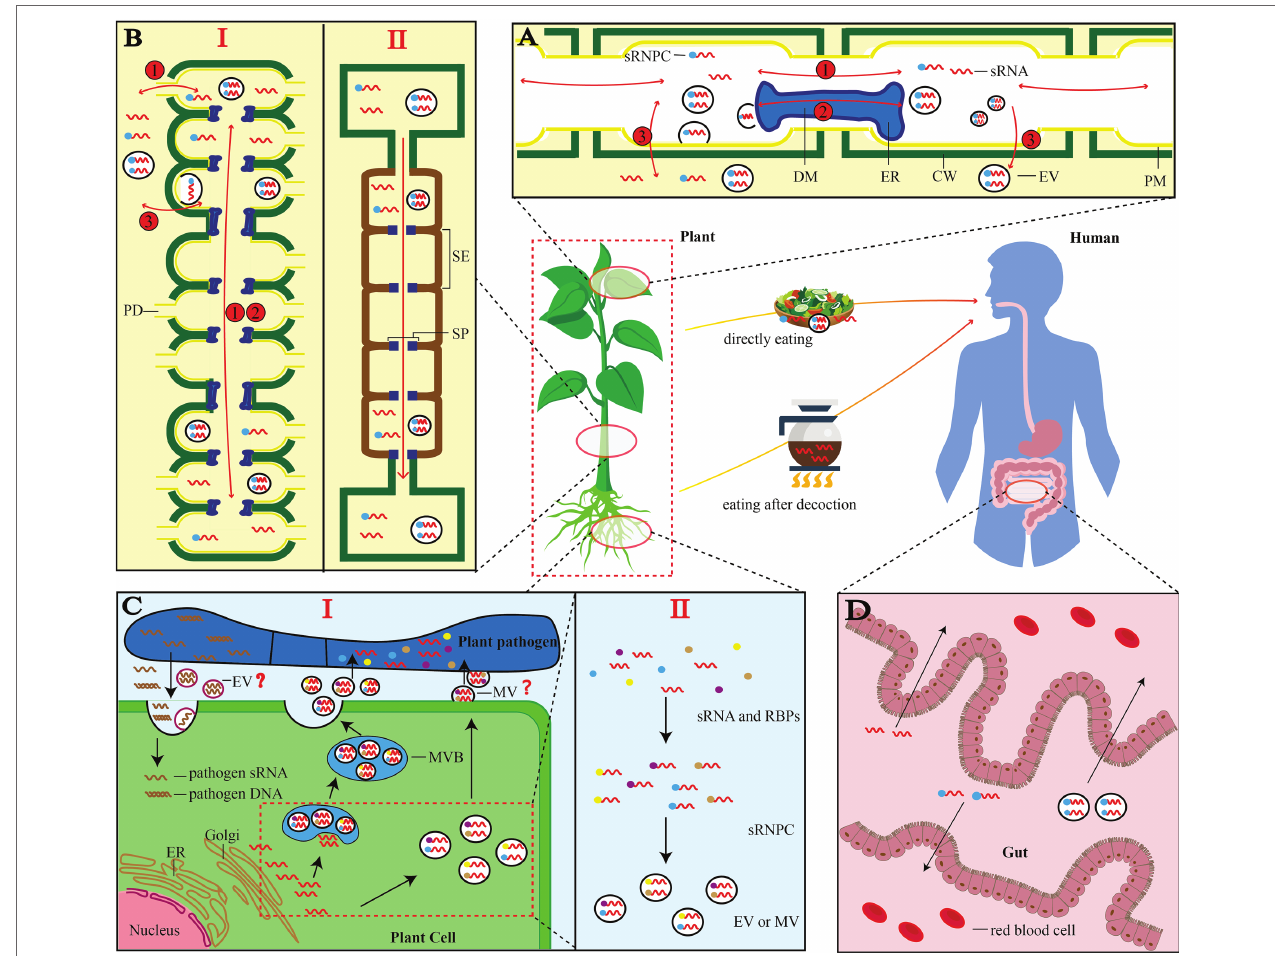
FIGURE 2 | Illustrations of siRNA trafficking in plants. (A) Movement between plant cells (Wang and Dean, 2020): Pathway 1, naked small RNAs, small RNAs bound to RNA binding protein (RBP) and small RNAs enclosed in vesicles can pass through plasmodesmata (PD) moves between cells; pathway 2, desmotubules (DM) connects the endoplasmic reticulum (ER) of two adjacent cells, and small RNA can be transported through DM; pathway 3, small RNA can be directly secreted from PM and spread in plants. Note: It is unknown whether vesicles can be transported via DM. (B) Long-distance movement in plants (Tamiru et al., 2018): I: Long- distance movement occurs through the repetitive mechanism of pathways 1 and 2 in the plasmodesmata; II: sRNA enters the phloem sieve tube through the plasmodesmata (PD), and transports it quickly from top to bottom with the phloem sap. (C) Cross-domain transport of sRNA by EV (Huang et al., 2019a): I: Free sRNA in plant cytoplasm can be packaged by Golgi and transported to the outside of the cell to be absorbed by Plant pathogen. At the same time, Plant pathogen also produces sRNA and delivers its own DNA or sRNA to plant cells; II: When vesicles are formed, sRNA needs to be combined with RBPs before it can be selectively loaded into EVs for cross-domain transport. Note: Plant pathogen here is only a type of organism that absorbs vesicles. Many organisms can absorb vesicles provided by plants or produce sRNA and transfer them to plant cells. “?” indicates whether plants can produce MV and whether other organisms can produce EVs is not yet clear; (D) Transfer of sRNA to animal cells: Plants deliver sRNA to the human body through decoction or raw food directly. After different forms of sRNA enter the gut, it is absorbed into the blood through the villi of the small intestine and circulates throughout the body with the blood. Human here refers to mammals. sRNA: small RNA; MVB: multivesicular bodies; sRNPC: sRNA ribonucleoprotein complex; DM: desmotubule; ER: endoplasmic reticulum; CW: cell wall; EV: extracellular vesicles; PM: plasma membrane; PD: plasmodesmata; SE: sieve tube elements; SP: sieve tube plates; MV: